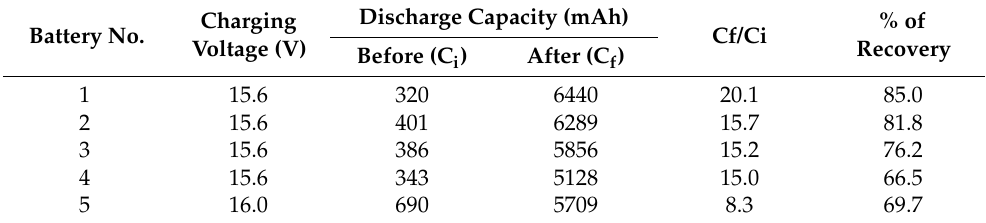
Table 6. Discharged capacities for the recovered batteries before and after charging. Battery No.